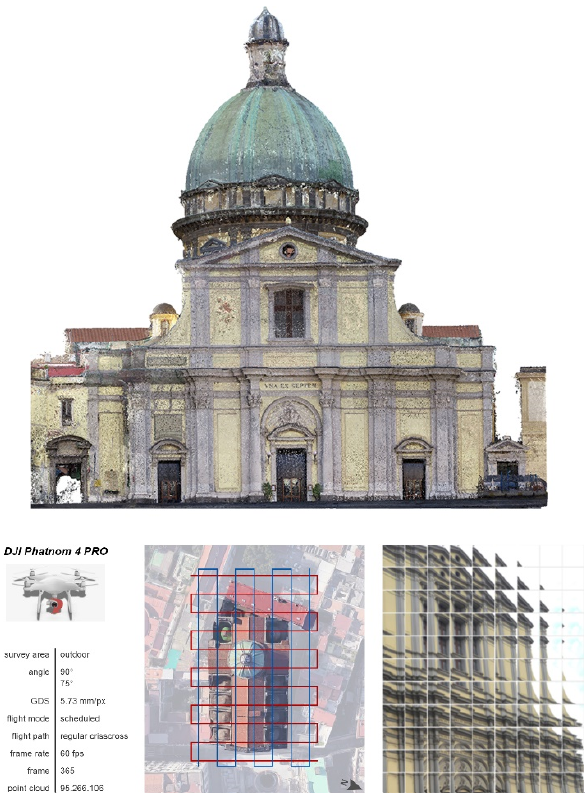
Figure 10. External image-based survey: settings and acquisition route , photographic dataset and processing results in